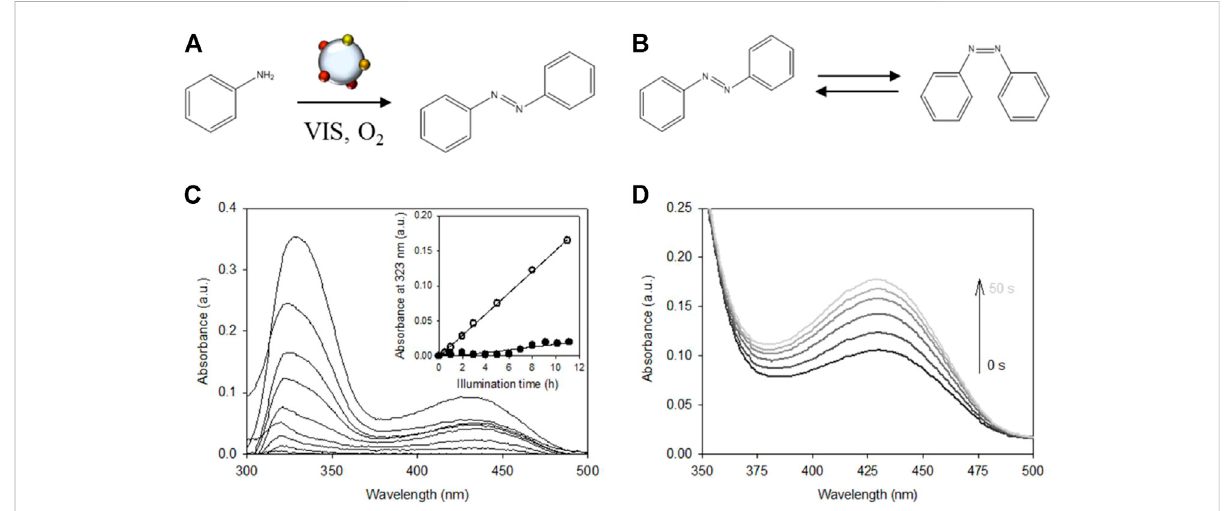
FIGURE 4 (A) Direct SPR mediated catalytic oxidation of aniline to azobenzene on SiO 2 supported rainbow catalyst. (B) trans - cis isomerization of azobenzene. (C) IncreaseinUV-VISabsorptionspectraoftheilluminatedreactionmixturehintingatazobenzeneformation.Opencirclesintheinset show the corresponding linear increase of the absorbance at 323 nm as a function of illumination time ( R 2 = 0.999). Filled circles represent the unilluminated dark experiment ( R 2 = 0.908). (D) Change in the UV-VIS absorption spectrum of the fi nal reaction product of (C) upon UV irradiation for 50 s. (B) shows the two isomeric conformations of azobenzene. The thermodynamically more stable trans -form ( t -AB) can photo- isomerize to its corresponding cis -conformation ( c -AB) under UV irradiation while the cis -to- trans back-isomerization occurs spontaneously in the dark. The absorption spectrum of t -AB in DMSO comprises a strong absorption at ~323 nm ( π → π * transition) and a weaker band at ~435 nm ( n → π * transition).The cis isomerhastwobandsintheUV,at~255 nmand~287 nm(both π → π *transition),andone n → π *transitionat~435 nmthatabsorbs more strongly than t -AB (Bandara and Burdette, 2012; Hallett-Tapley et al.,